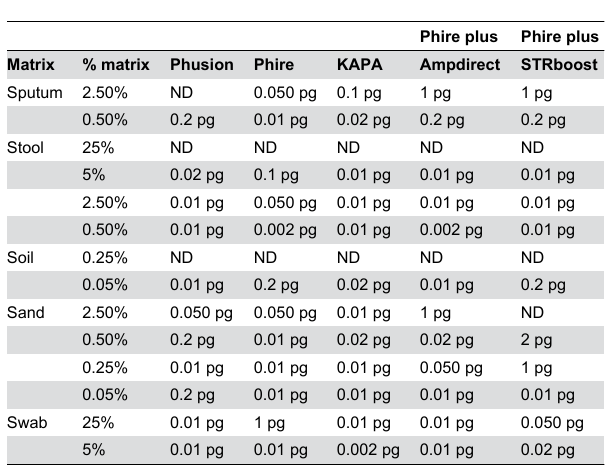
Table 6. Preliminary estimation of LOD down-selected inhibitor-resistant reagents for sputum, stool, soil, sand, and swab.